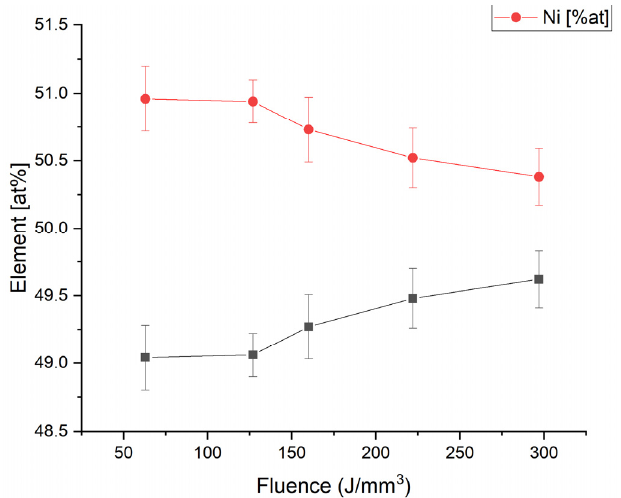
Figure 5. Compositional analysis, carried out with EDS, of the NiTi built samples processed at different laser fluence values.